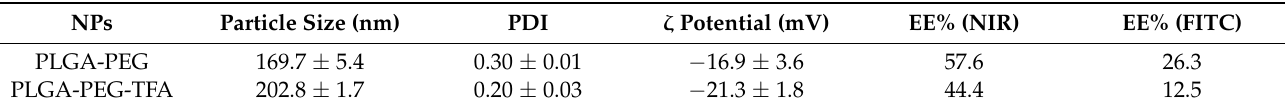
Table 1. Characteristics of the PLGA-PEG and PLGA-PEG-TFA